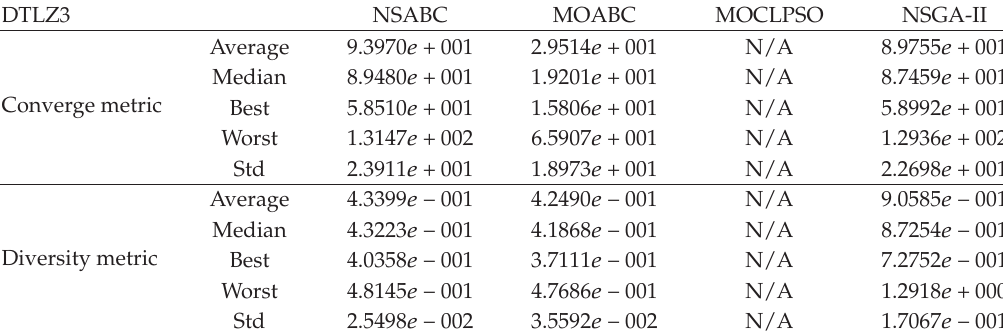
Table 20: Comparison of performance on DTLZ3 after 20000 FEs.